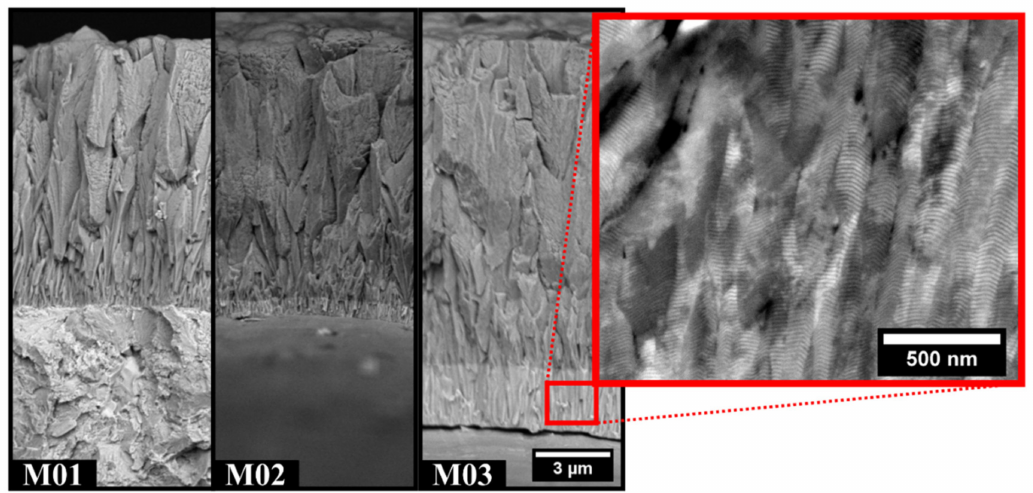
Figure 3. The fractured cross-sections using backscattered signal showing the multilayer thickness and the presence of a thicker base layer for M03. In detail, an electron channeling contrast image shows the multilayer structure present in the base layer.